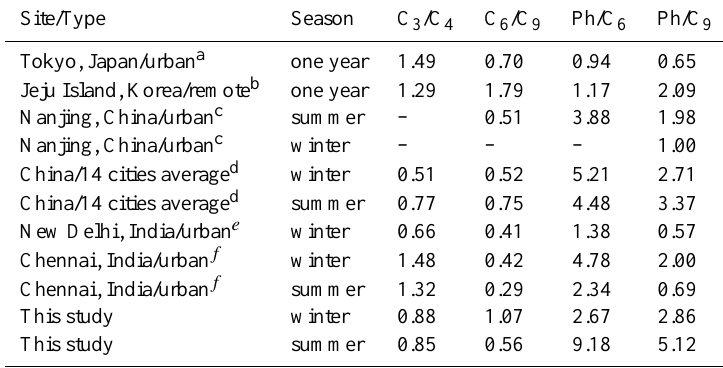
Table 2. Weight ratios of selected diacids in Himalayan aerosols with the literature data.